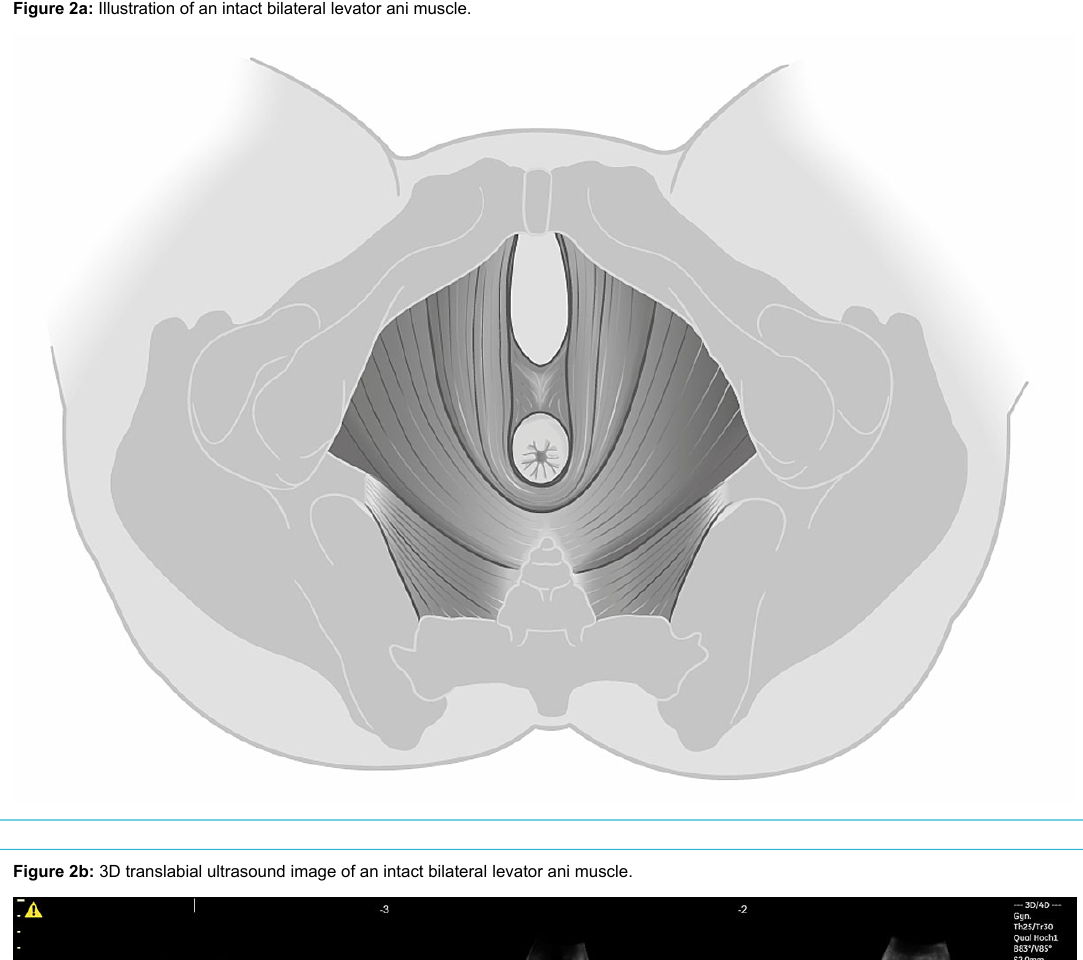
Figure 2a: Illustration of an intact bilateral levator ani muscle.